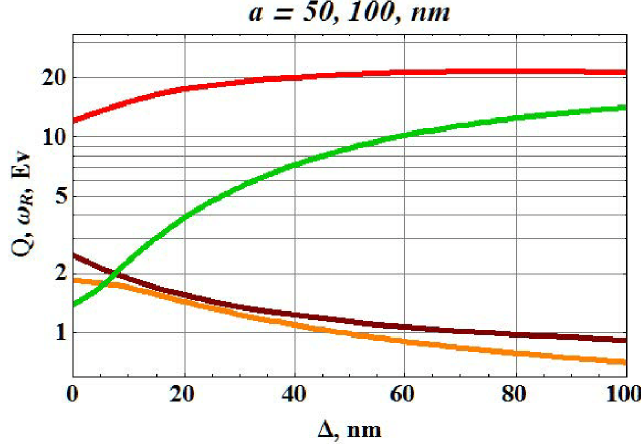
Figure 12. Resonance frequency ω r (brown and orange curves) and Q -factor (red and green curves) of the gold-dielectric resonator, displayed in Figure 11, as function of the shell thickness ∆ (refractive index of dielectric shell is n = 4). Brown/red and orange/green curves correspond to the gold core radius a = 50nm, and a = 100nm, respectively, reprinted with permission from [18], the Optical Society